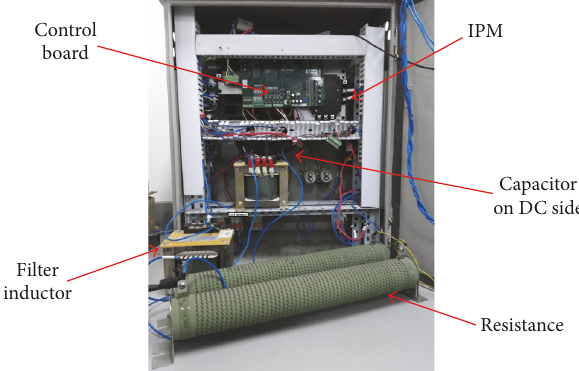
Figure 6: Harmonic injection component of PWM modulated wave.